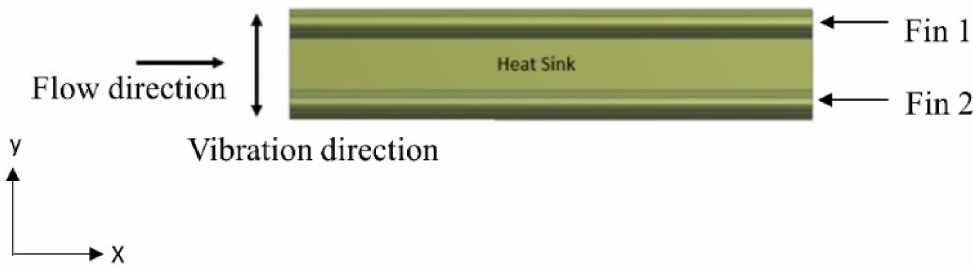
Figure 7. Top view of the heat